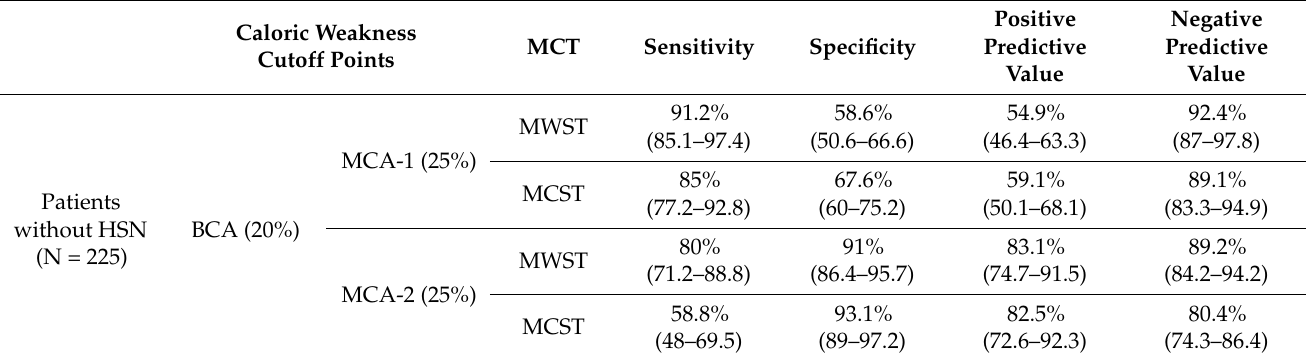
Table 2. Results of MCT for both warm and cold stimulation in comparison with BCT among non-HSN